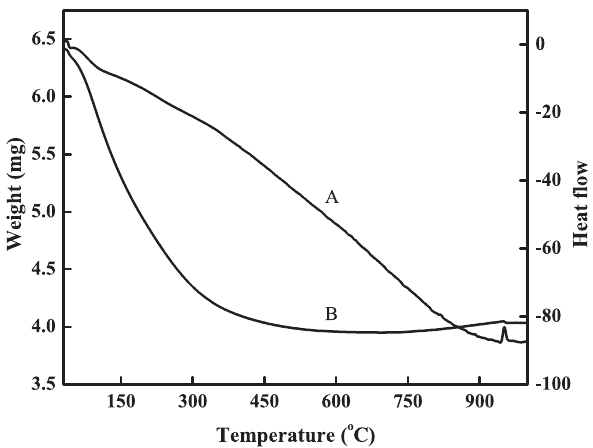
Fig. 4: TG/DTA curve of particles shown in Fig.